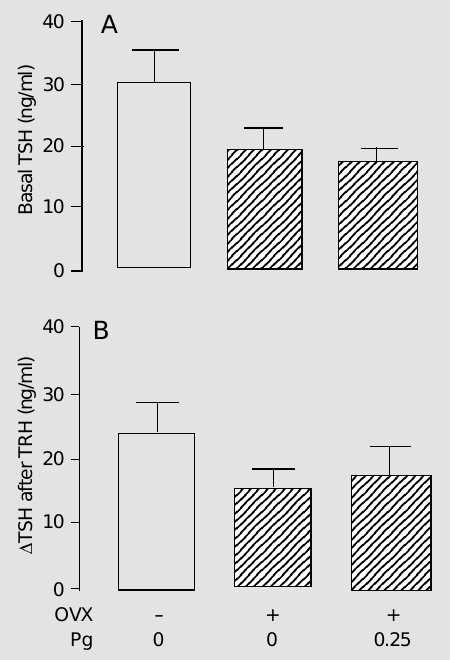
Figure 3 - In vitro basal (panel A) and TRH-stimulated (panel B) TSH release from hemipituitaries of young adult (3 months old) sham-operated or ovariectomized (OVX) rats treated with medroxyprogesterone acetate (MPA, 0.25 mg/100 g body weight, sc , for 9 days) or saline. After incubation, pituitary TSH content was measured (panel C). Number of hemipituitaries per group: 6-8; *P<0.05 vs normal and OVX; **P<0.05 vs normal and OVX + MPA (ANOVA followed by New- man-Keuls test). D TSH values were calculated as the difference between medium TSH and basal TSH after TRH.